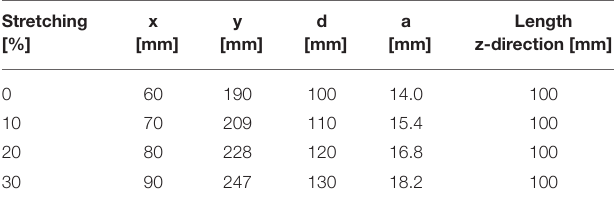
x is the length of the stretchable segment. y is the distance between the ends of the two stretchable segments of the double loop. d is the total width of one element. a is the overlap distance between the two coils (see also Figure 1A ).